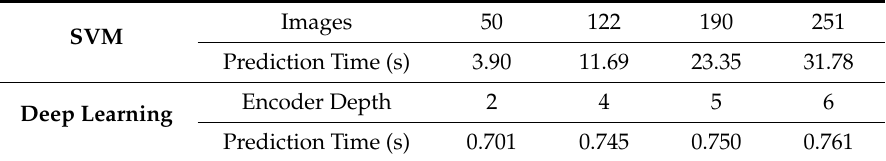
Table 5. SVM and deep-learning prediction time.